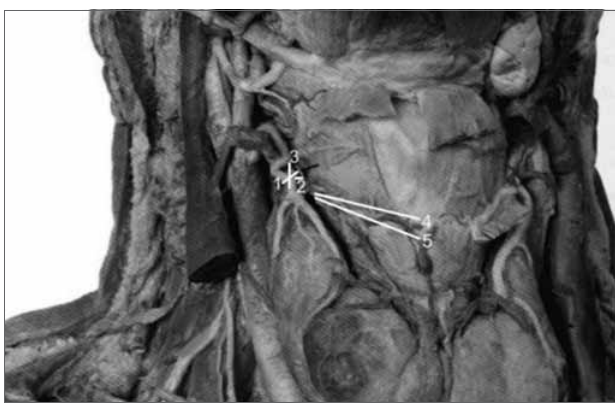
Figure 1. Antero-lateral area of the dissected neck, exposing the thyroid gland and associated structures. White lines and numbers correspond to measurements 1 to 5 described above. - (Adapted from McMinn, Hutchings & Logan, 1994)